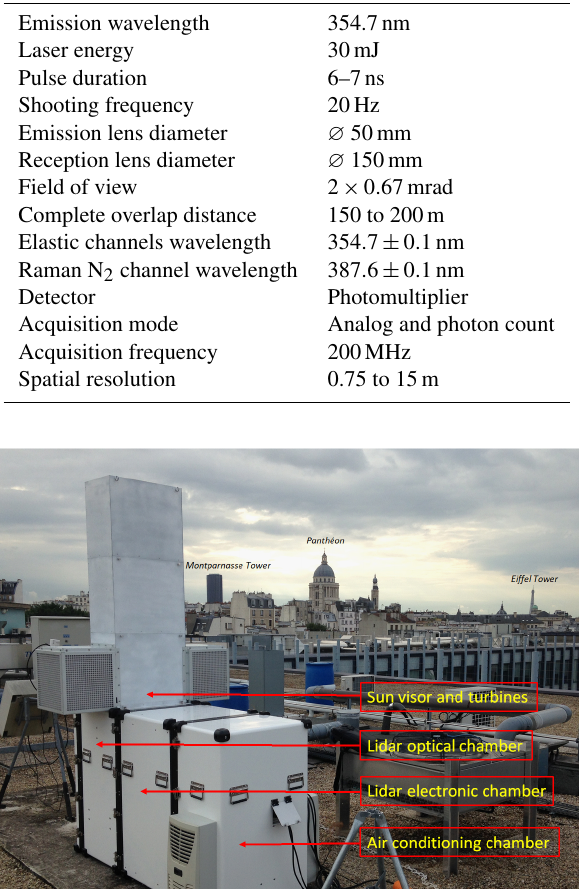
Table 1. LAASURS characteristics.